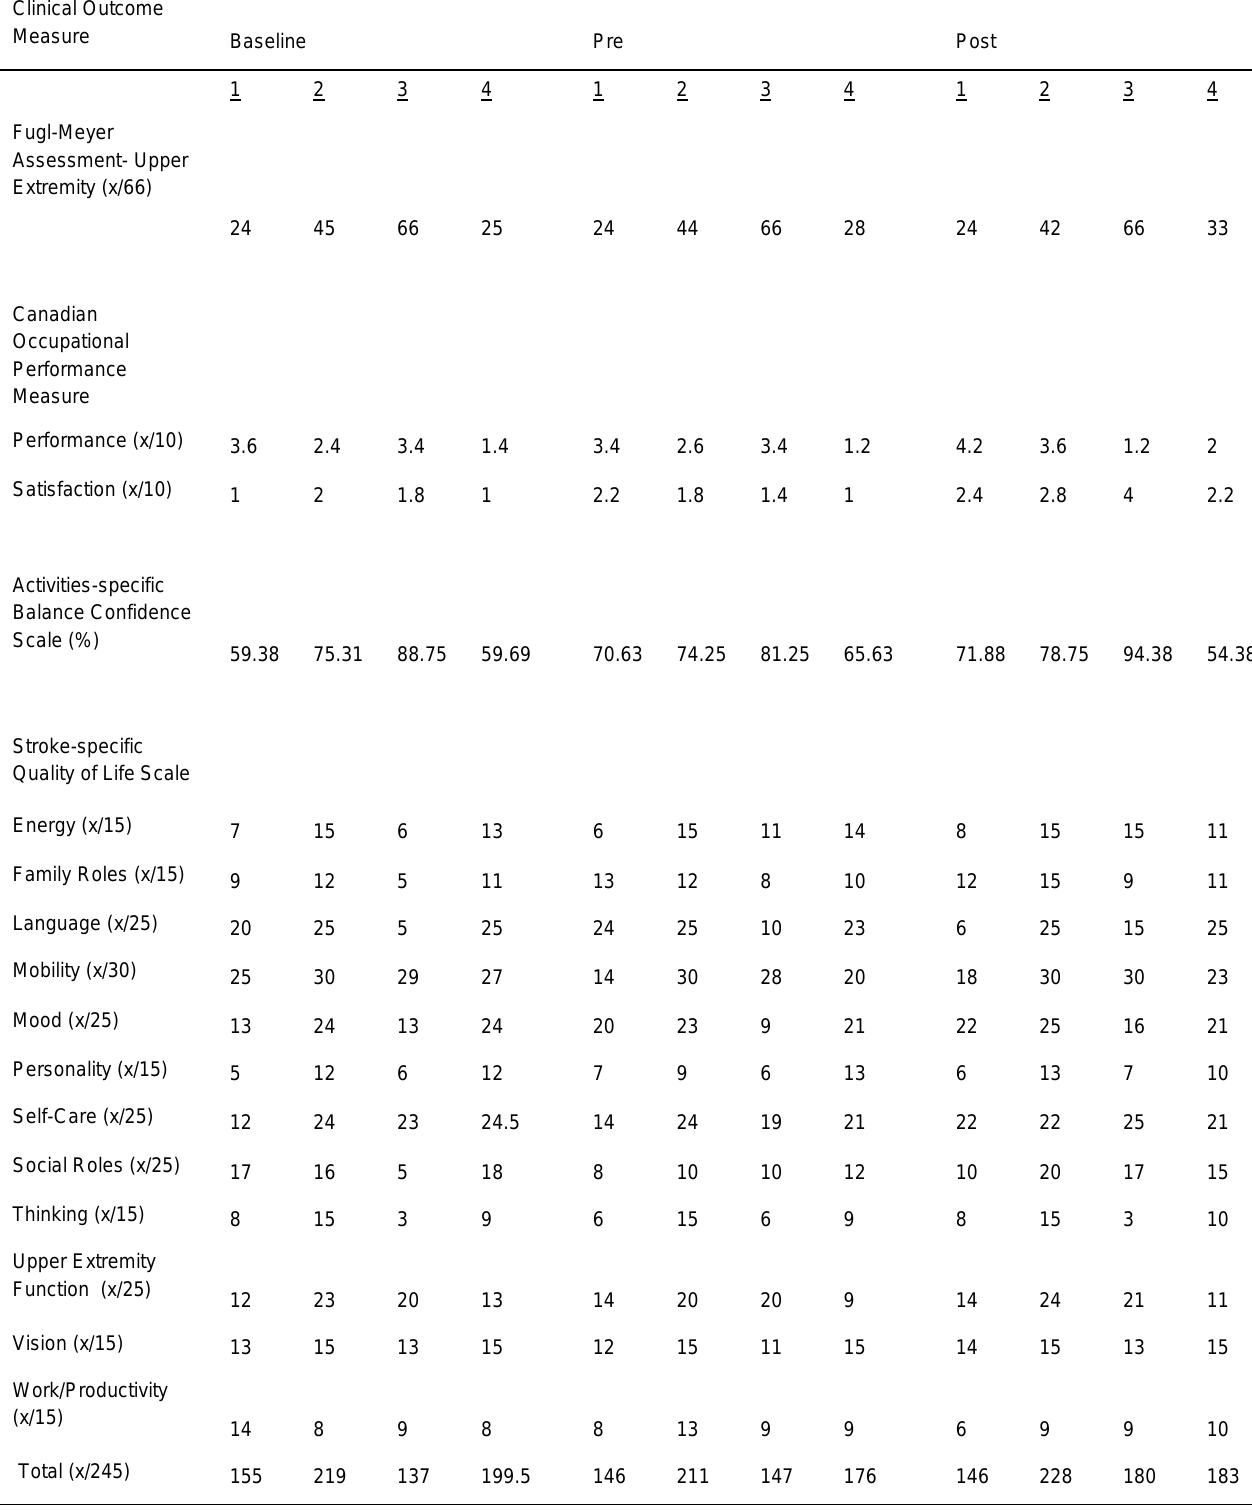
Table 3. Results of Clinical Outcome Measures for Each Participant at Three Time Points Clinical